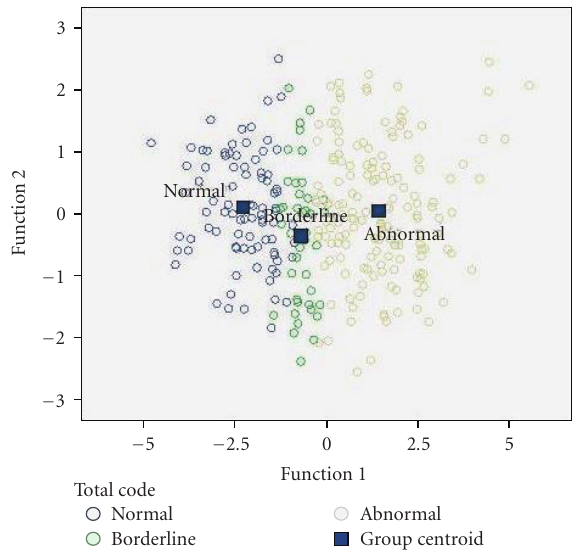
Figure 2: Canonical discriminant